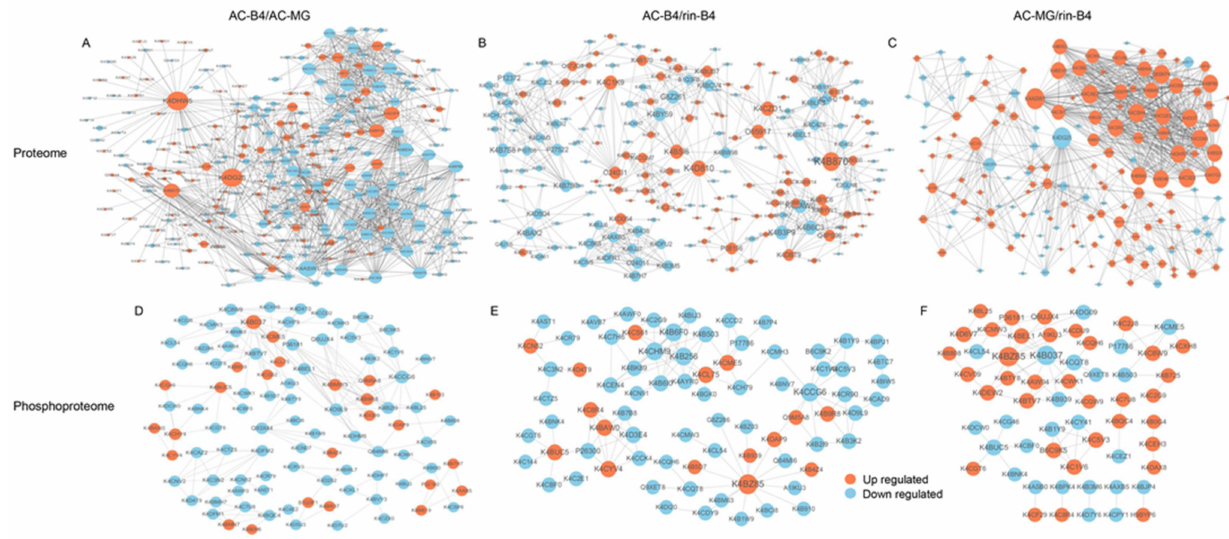
Figure 11. Protein–protein interaction network. Protein–protein interaction network for proteins corresponding to represen- tative DEPs (proteome, ( A – C )) and DEPPs (phosphoproteome, ( D – F )) in different comparison